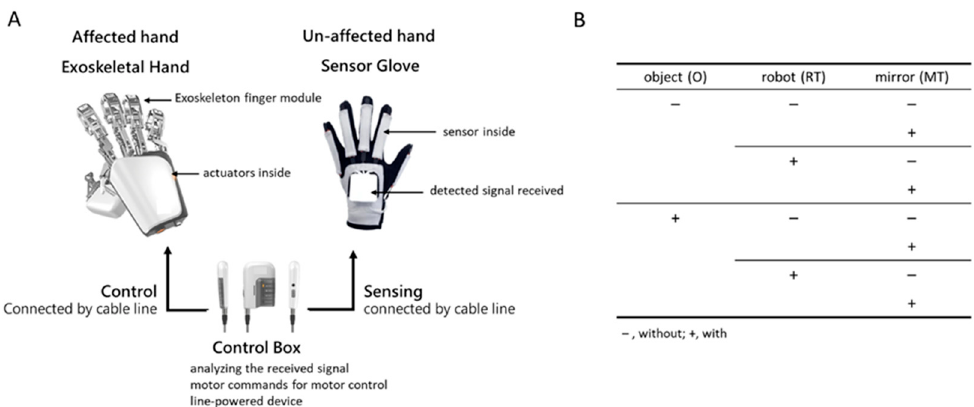
Figure 1. The exoskeleton hand device and the study design. ( A ) The exoskeleton hand device; ( B ) the diagram of 2 (with vs. without object manipulation) × 2 (with vs. without robot-assisted) × 2 (with vs. without mirror) factorially experimental design.